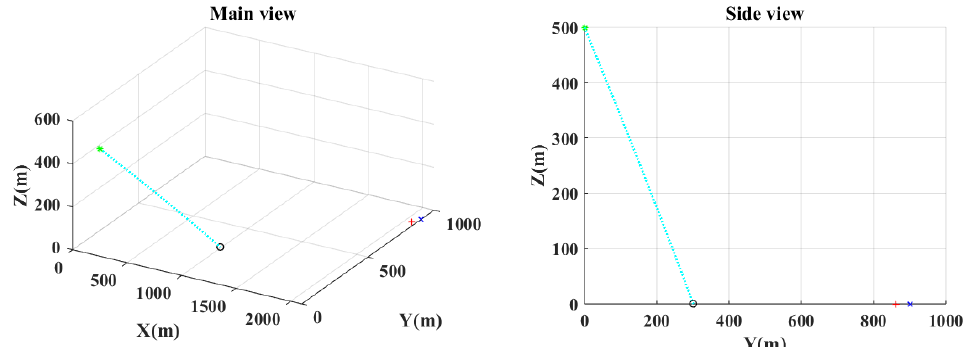
Figure 7. The ballistic of PSO in case 1.